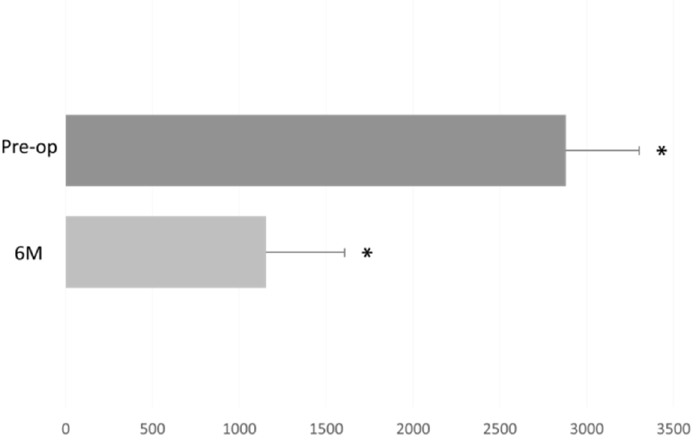
Figure 6. Donor endothelial cell density (ECD) before and after DMEK “Wave Maneuver” operation. Graph displaying the donor ECD before (Pre-op) and six months after DMEK “Wave Maneuver” operation. M: months. Asterisk represents statistical significance ( p < 0.01) for Pre-op versus 6M.